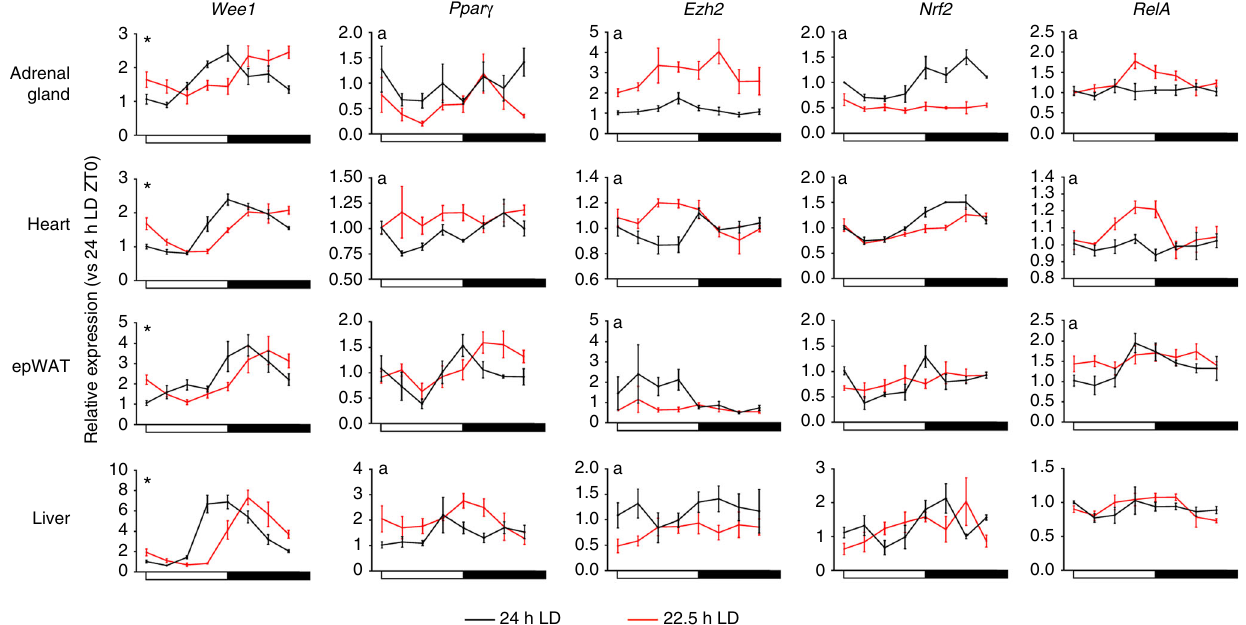
Fig. 4 Phase misalignment disrupts rhythmic gene expression in a pathways and tissue-speci fi c manner. Transcript pro fi les of major clock-controlled regulator genes of cell cycle ( Wee1 ), epigenetic regulation ( Ezh2 ), metabolism ( Ppar γ ), oxidative stress ( Nrf2 ) and in fl ammation ( RelA ) from mice housed in 24 or 22.5 h conditions for 17 weeks. All data plotted mean ± SEM relative to the respective light cycle (24 or 22.5 h) and normalised to ZT0 of the 24 h LD group ( n = 4/time-point/group). ∗ Signi fi cant ( p < 0.05) difference in phase between 24 and 22.5 h pro fi les; a = signi fi cant difference in amplitude or mesor between 24 and 22.5 h LD conditions (sinusoidal waveform fi ts with F tests for shared